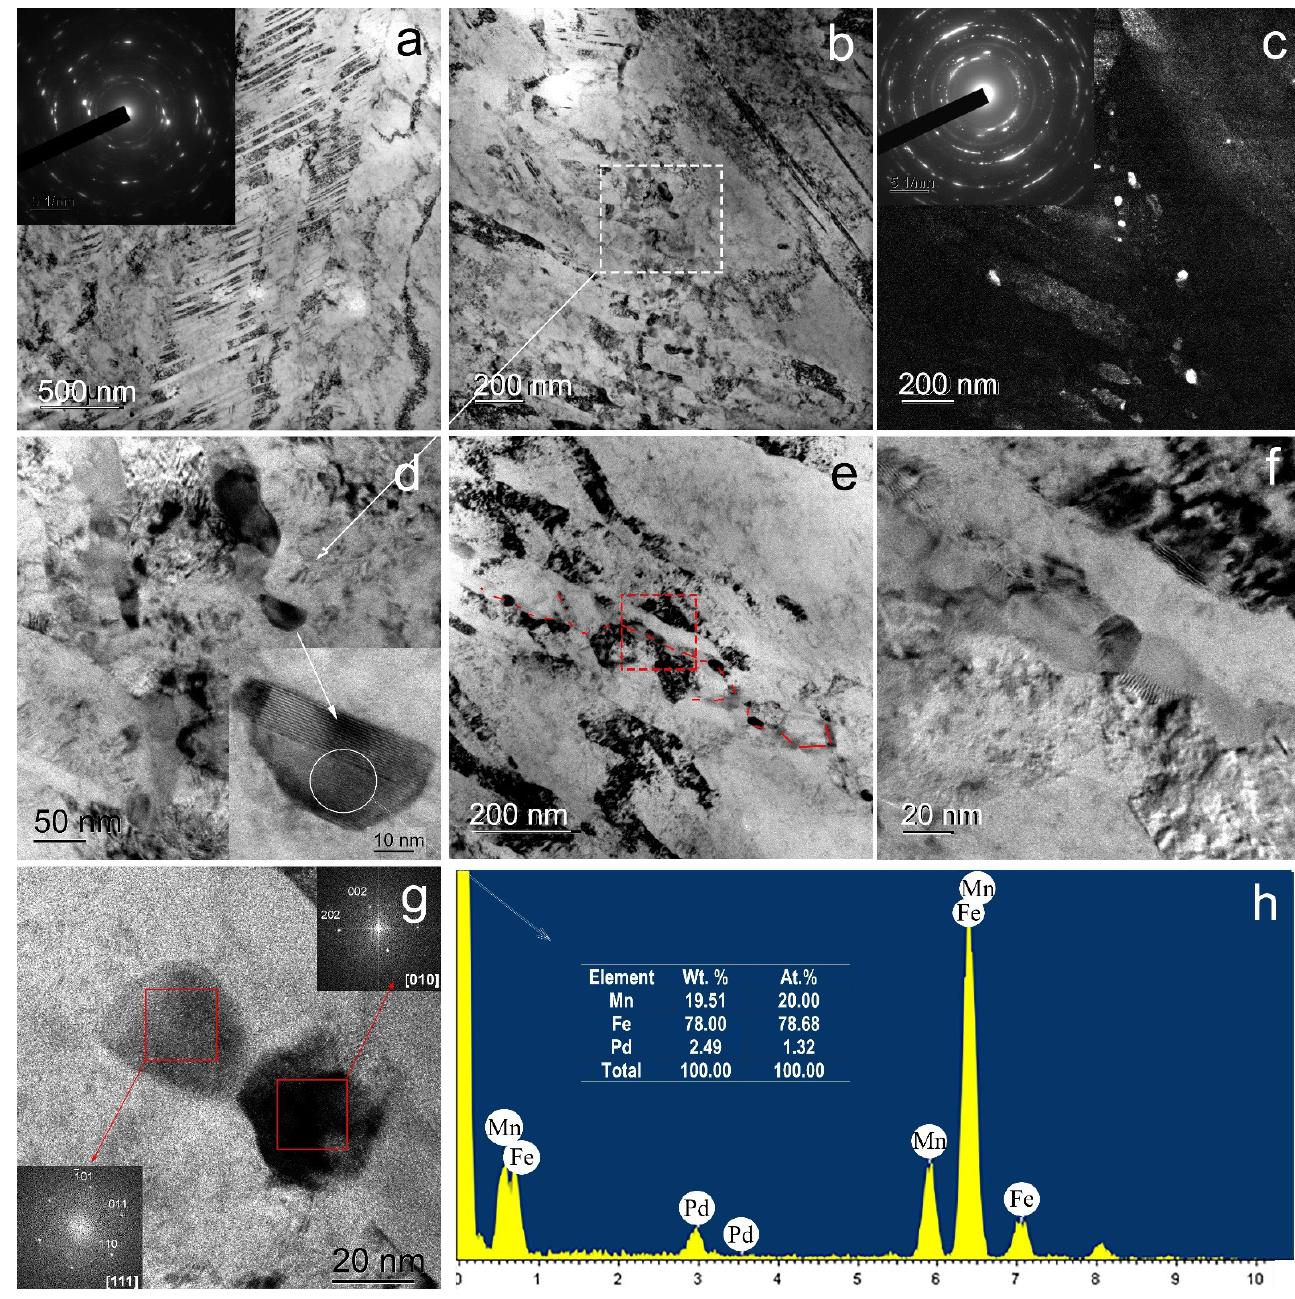
Figure 5. TEM images of Fe–Mn–Pd alloy after ECAP at 450 °C: ( a ) BF image of twins area with SAED pattern can be seen in the inset; ( b , d – f ) BF image of subgrain area; ( c ) DF image of subgrain area with SAED pattern can be seen in the inset; ( g ) HRTEM of Mn 2 Pd 3 particle with FFT pattern from Mn 2 Pd 3 particle can be seen in the inset; ( h ) and TEM-EDS point analysis result of the particle.